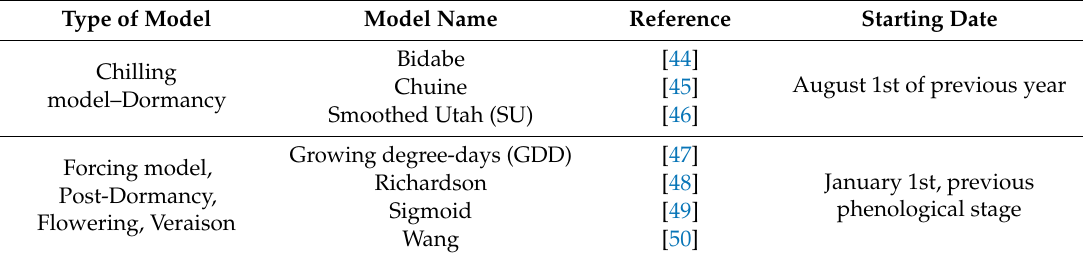
Table 2. Phenological models used in the present study, along with their relevant bibliographic references and pre-defined starting dates.